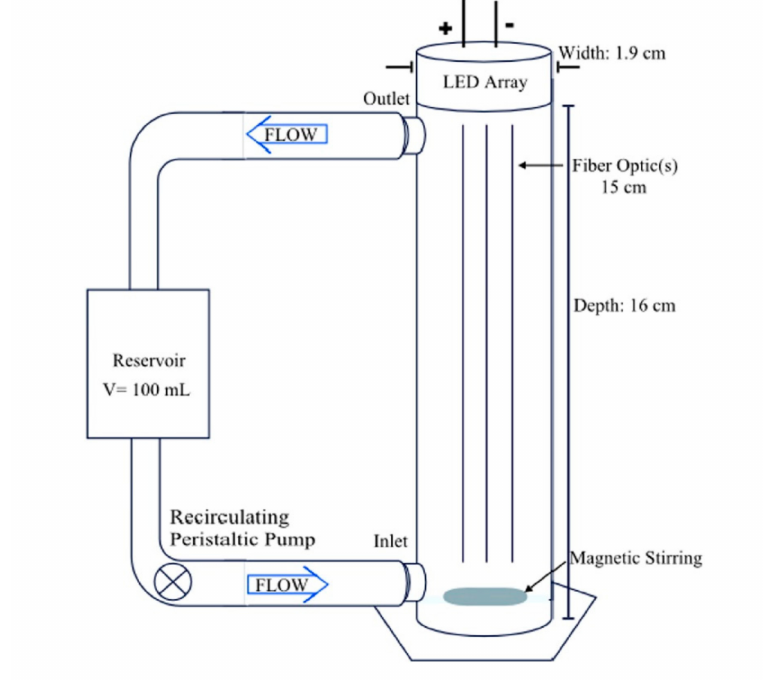
Figure 3. Flow-through optical fiber (OF) / LED reactor design